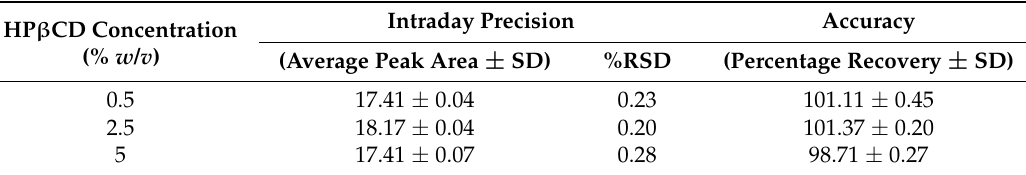
Table 1. Intraday Precision and Percentage Recovery for HP β CD standard